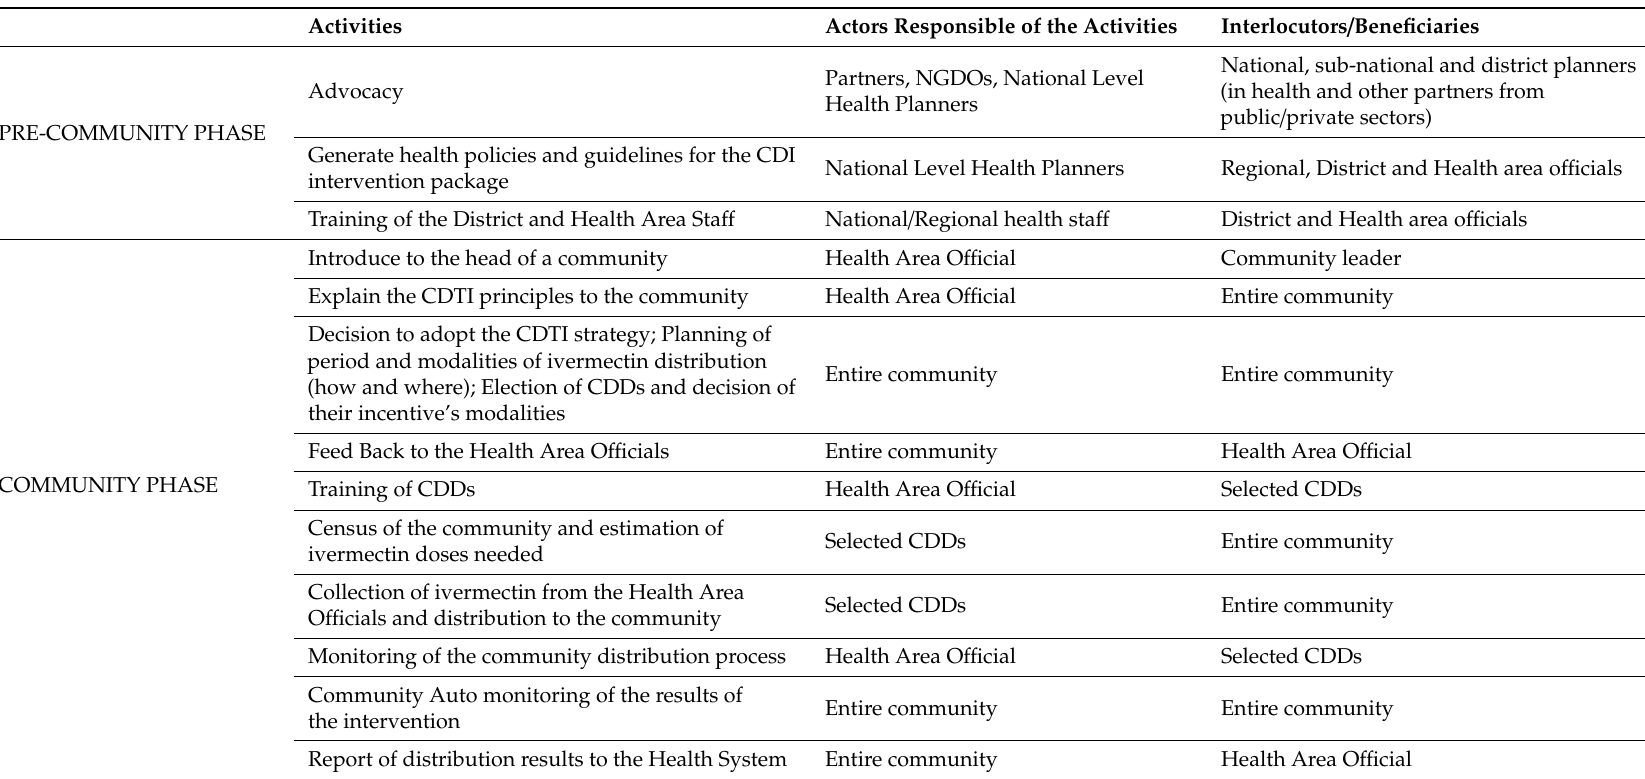
Table 1. Process and role distribution in the CDTI / CDI 1